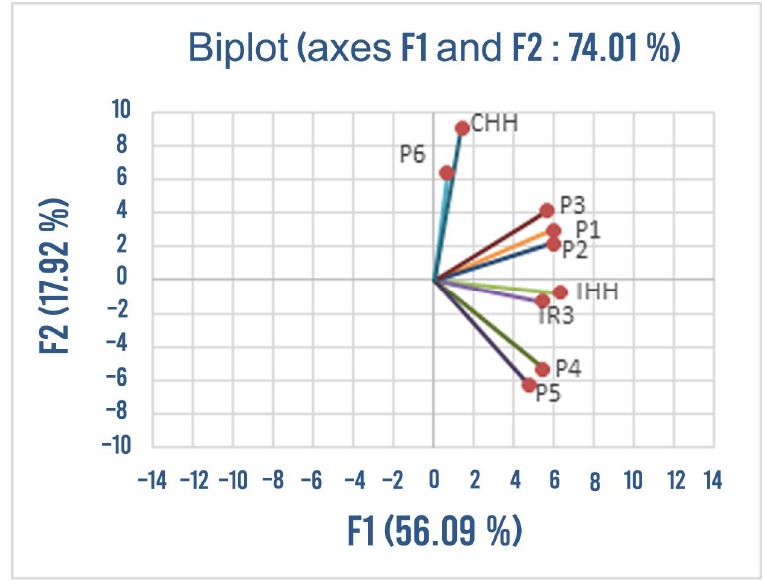
Figure 12. Correlation biplot: observations and variables.